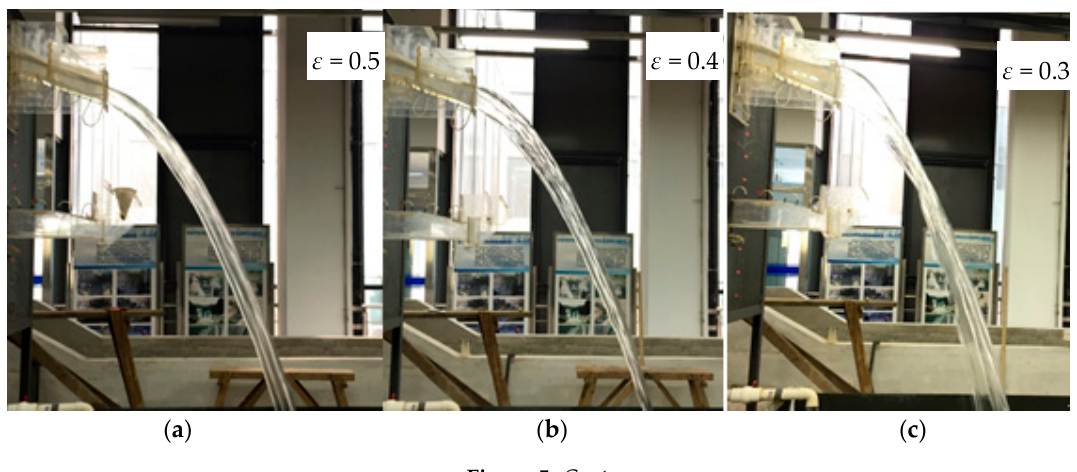
Figure 4. Relationship between the upstream water head and the flow coefficient with different contraction ratios for fresh water and sediment-laden flow with concentrations of 150 kg/m 3